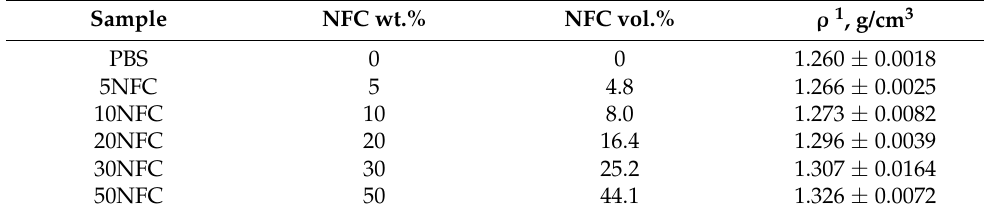
Table 1. Prepared PBS/NFC composites and their